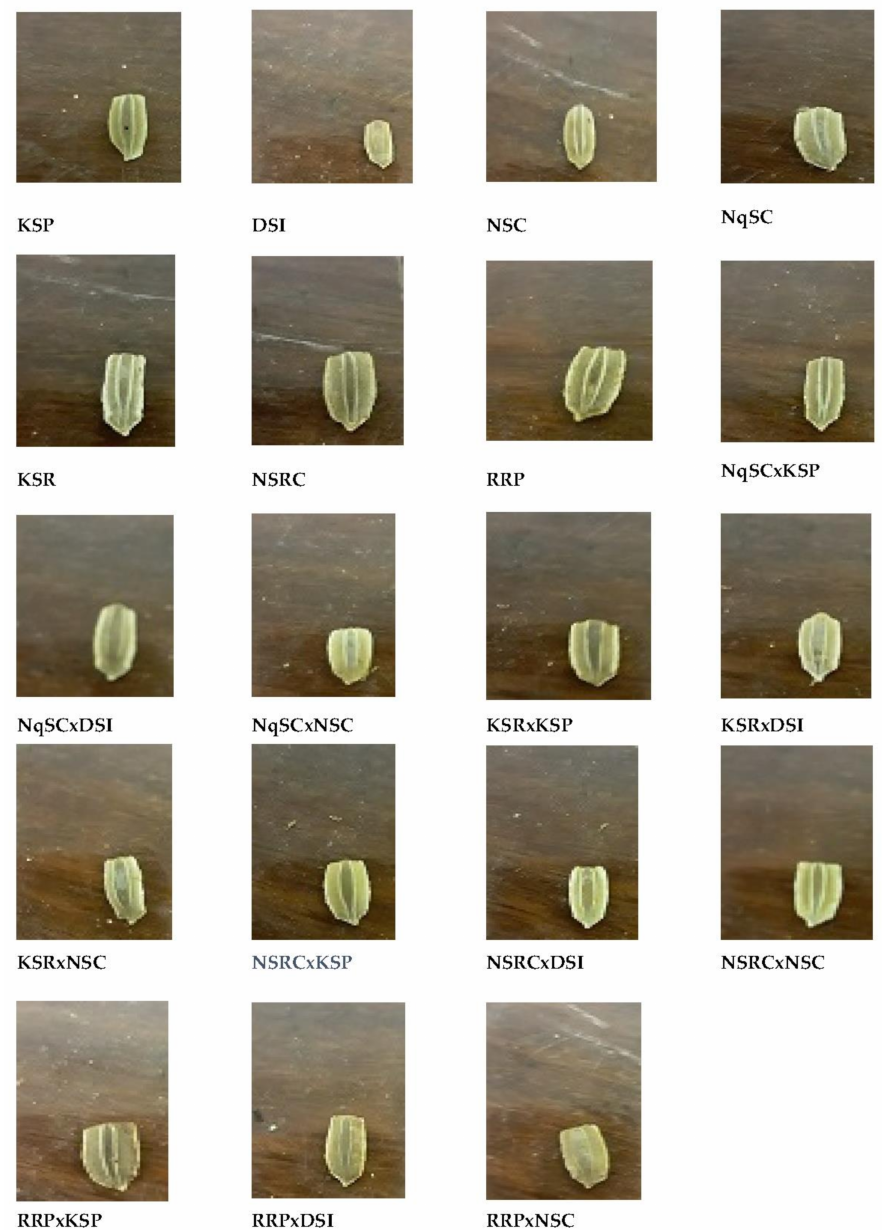
Figure 3. Diversity in seed color and seed shape among Lagenaria siceraria